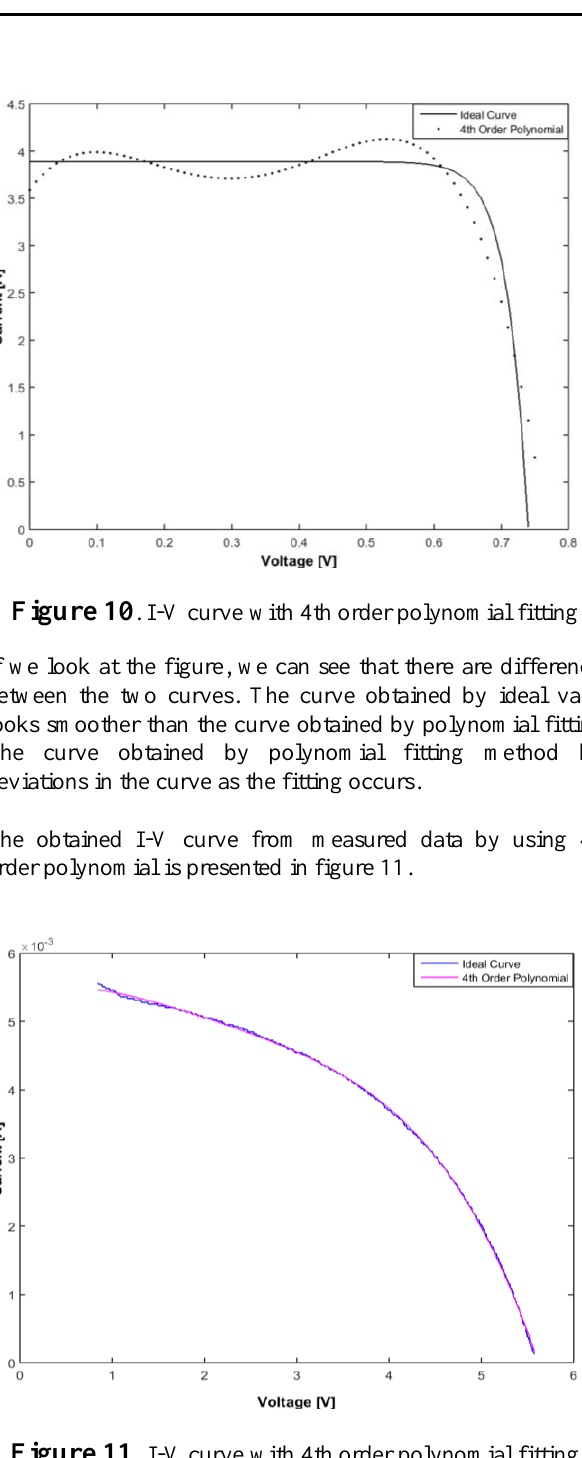
Figure 13 . P-V curve with 4th order polynomial fitting. The above figure is the power-voltage (P-V) curve obtained from measured data. The curve in blue is the ideal power-voltage curve obtained from measured data. And, the other is the fitted curve by using fourth order polynomial